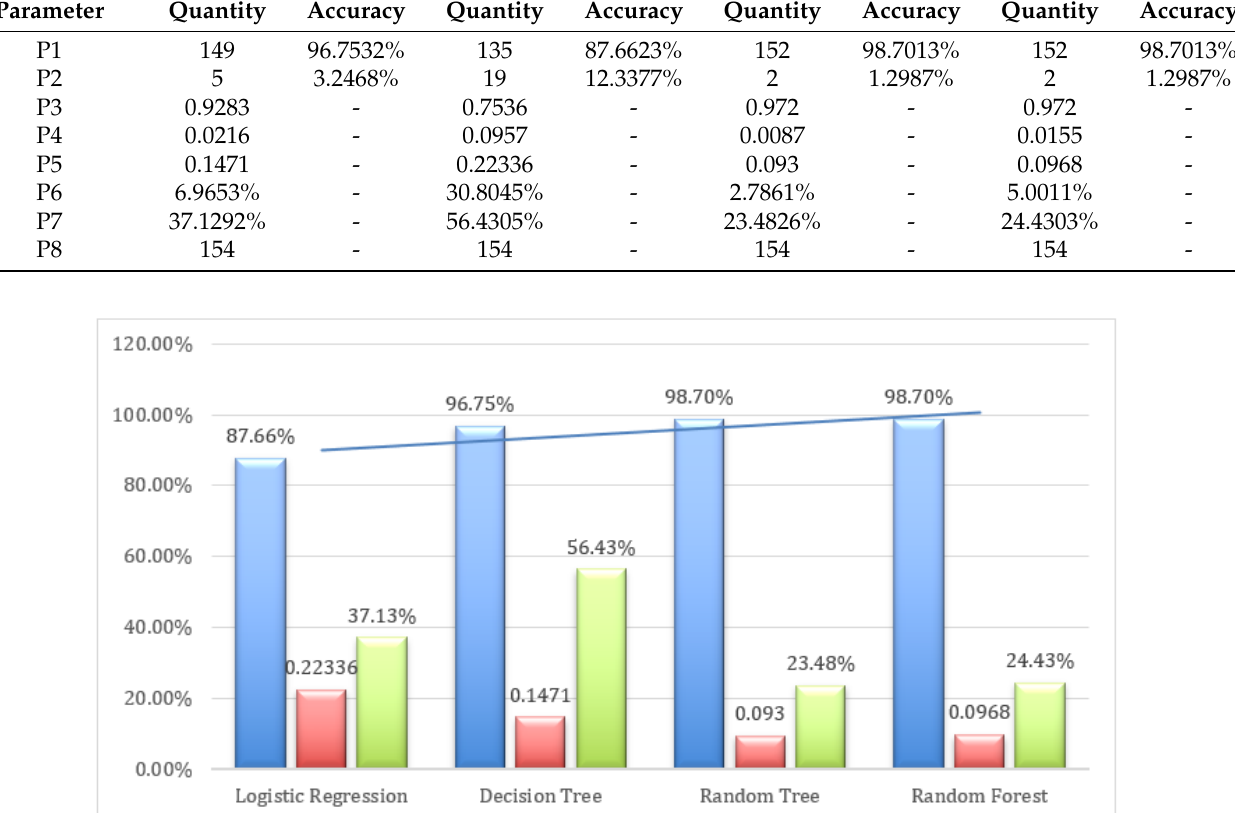
Figure 13. Performance comparison of various machine learning